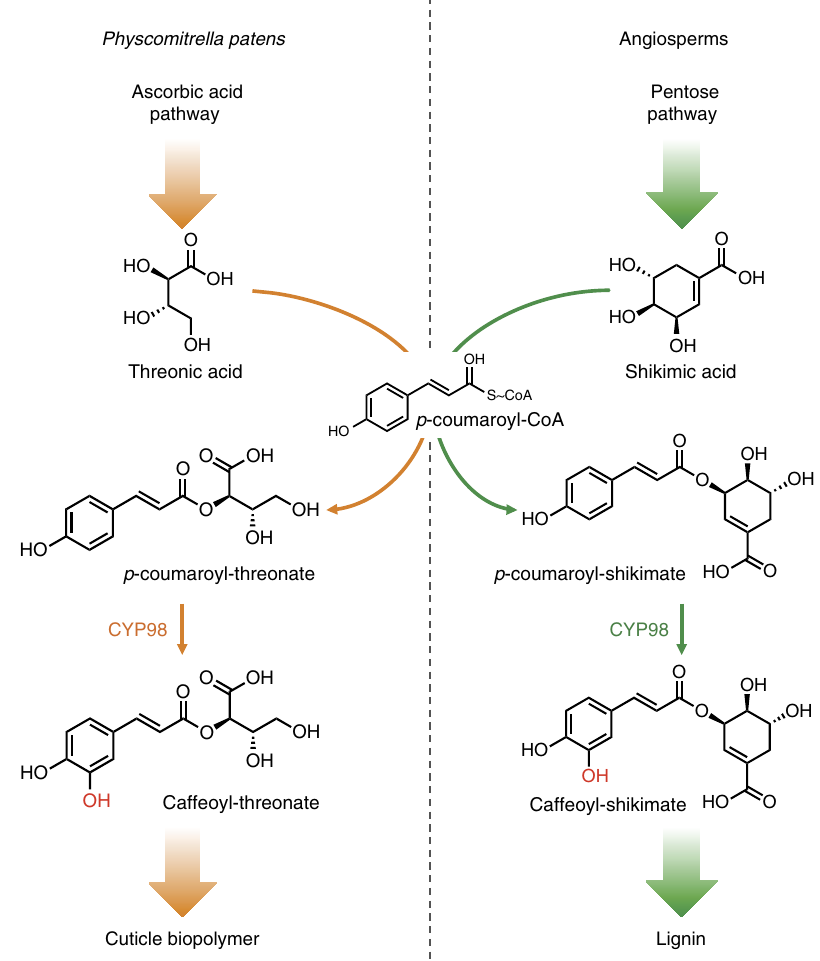
Figure 1 | The hydroxycinnamoyl-shikimate pathway in angiosperms and the P. patens hydroxycinnamoyl-threonate pathway established in this study. The figure shows p -coumaroyl-2-theonate as PpCYP98 substrate, but p -coumaroyl-4-threonate is also converted by the enzyme. The p -coumaroyl- shikimate molecule is drawn according to the structure experimentally determined by Levsh et al. 39